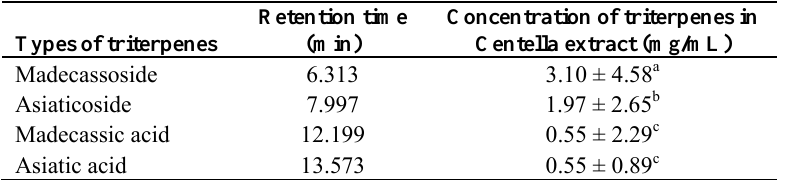
Table 1. Triterpene concentration of Centella